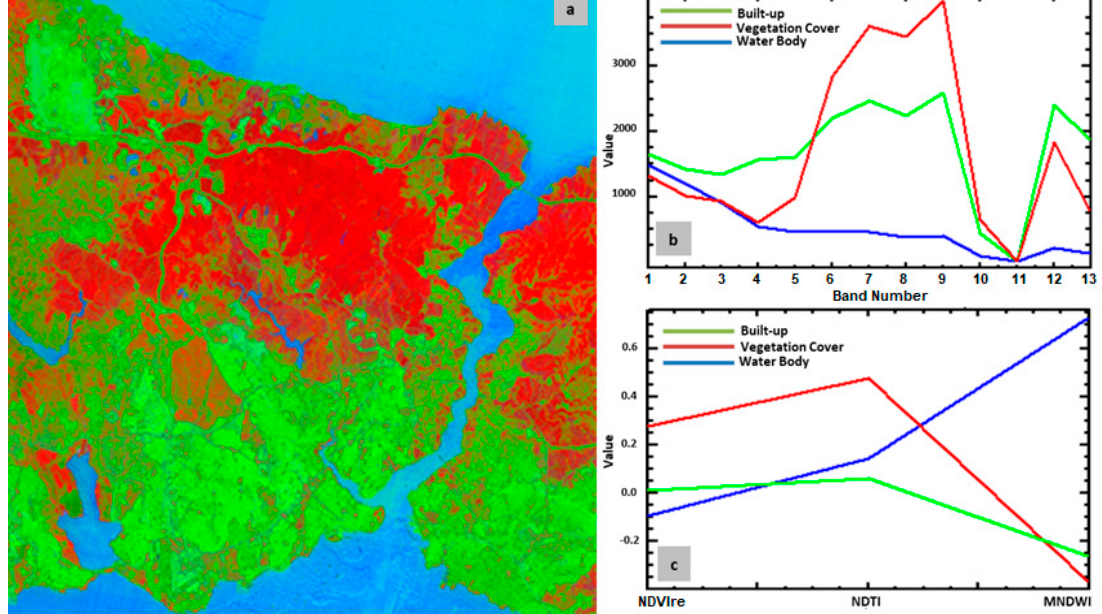
Figure 6. ( a ) RGB composite of the NDTI, red-edge-based normalized vegetation index (NDVIre), and the modified normalized difference water index (MNDWI). ( b ) Spectral signatures represented by the mean of the three major categories of land cover for the thirteen bands of the Sentinel-2A image. ( c ) Simplified spectral signatures represented by the mean of the three major categories of land cover for the multi-index image.